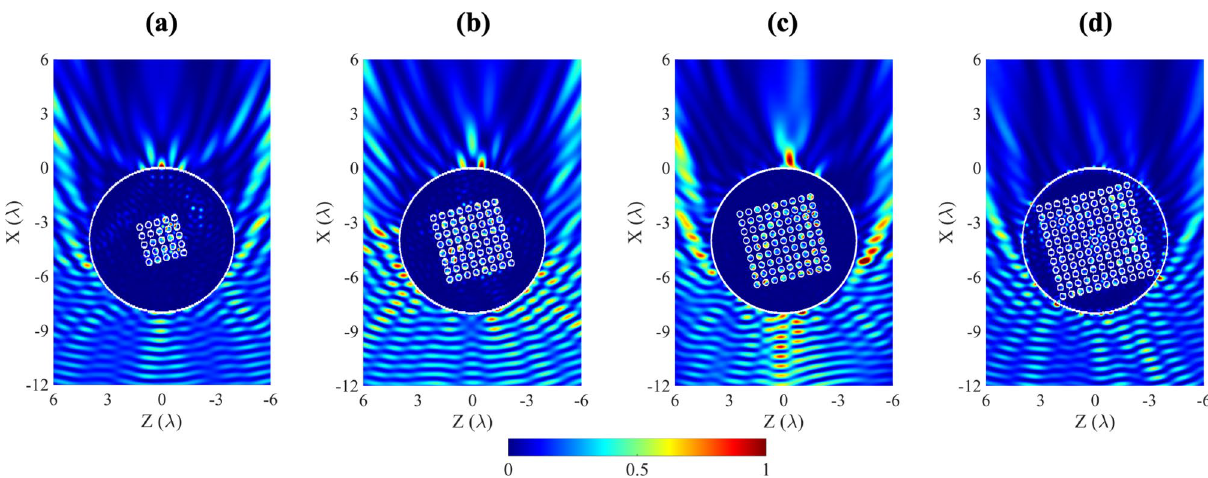
Figure 4. Normalized intensity plane ( I / I max ) for ABS cylinder with an embedded ( a ) 5 × 5 , ( b ) 8 × 8 , ( c ) 9 × 9 and ( d ) 11 × 11 PhC which is rotated θ = 15 ◦